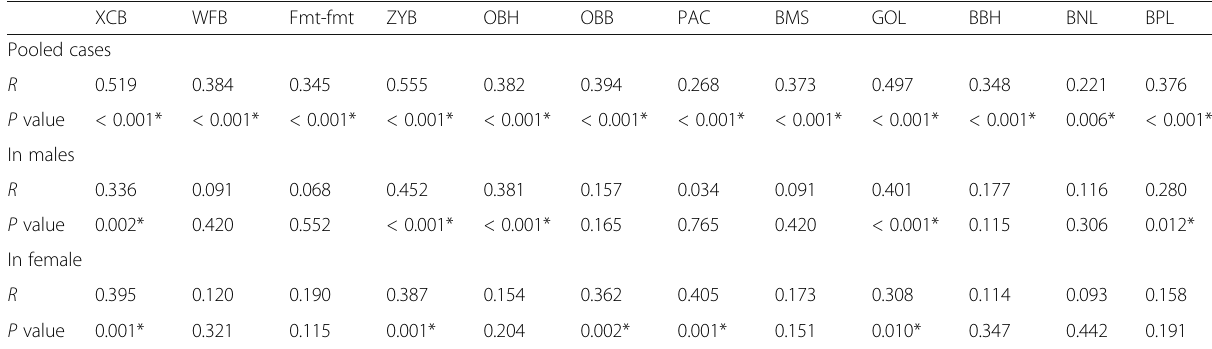
Table 4 Correlation between the stature and skull measurements in pooled cases ( n = 150), males ( n = 80), and females ( n = 70) by Pearson ’ s correlation coefficient Pooled cases